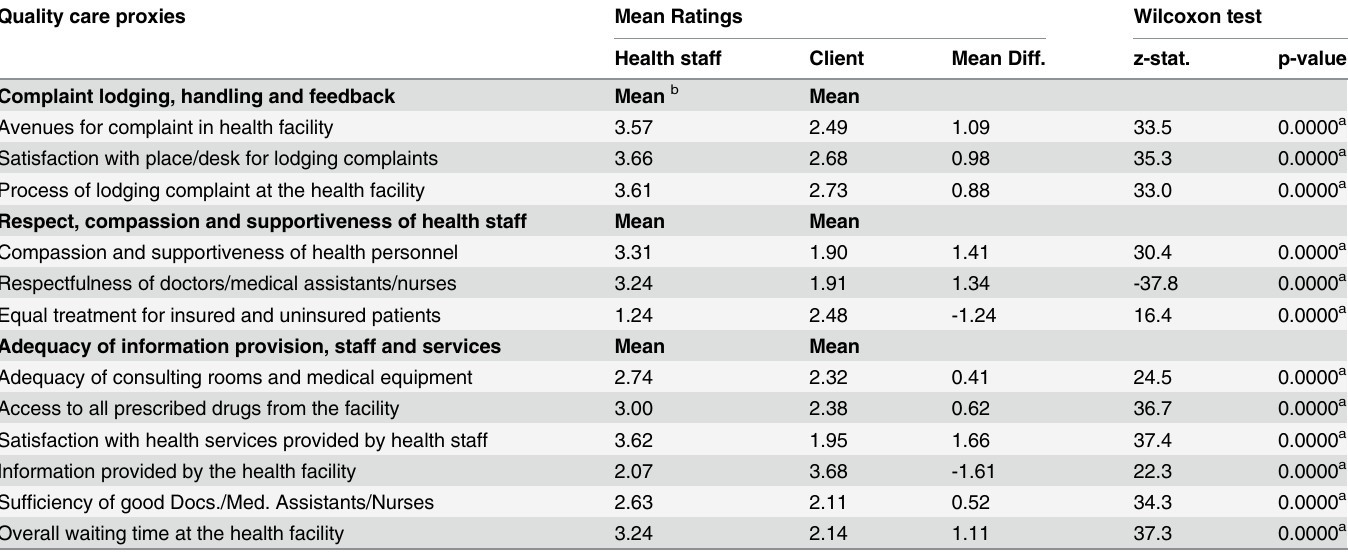
Table 2. Differences in client and health staff perceptions of healthcare